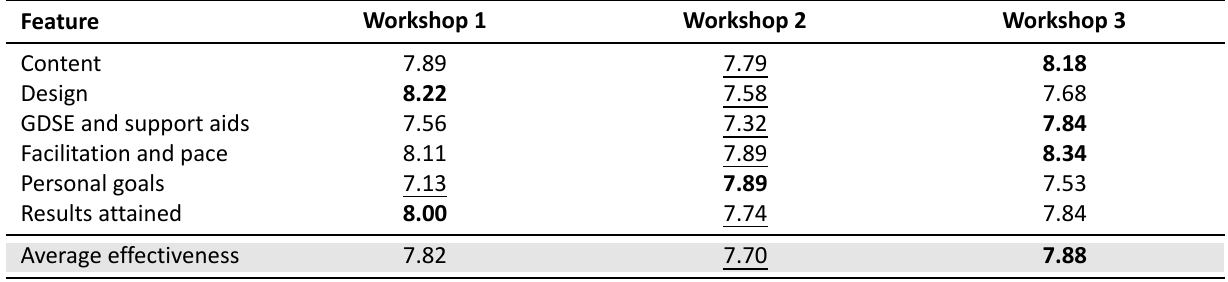
Table 6. PULL workshop ratings. Values in bold denote maximum. Underlined values denote minimum.